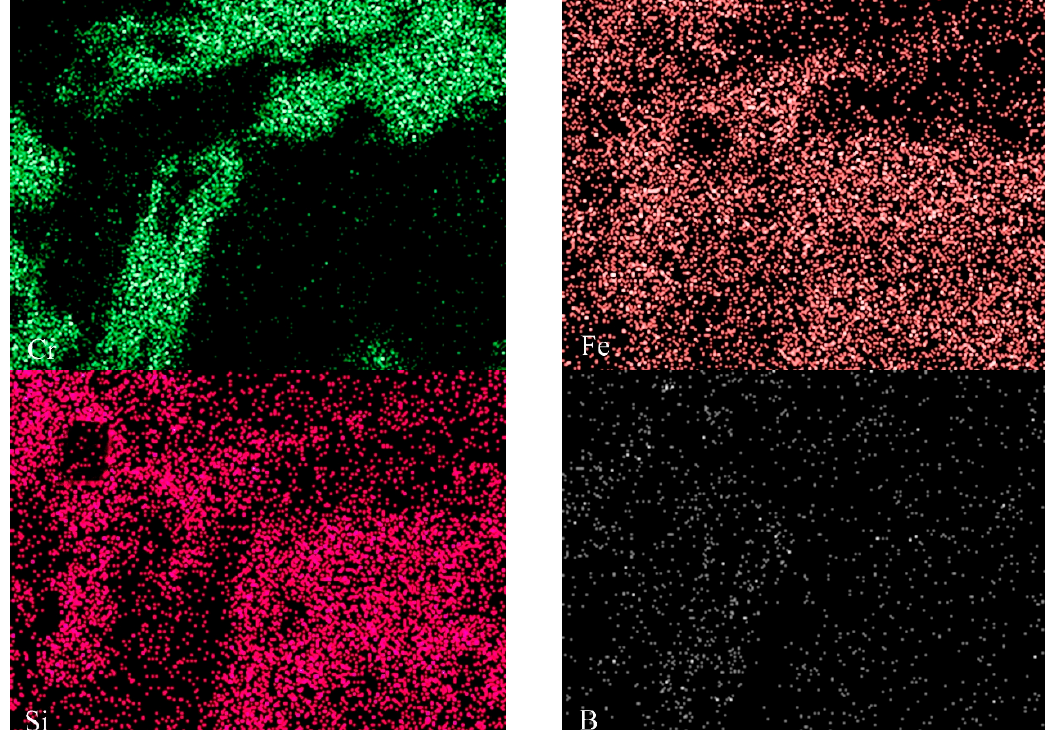
Figure 5. SEM microstructure and corresponding EDS analysis results of the composite coating with P4.